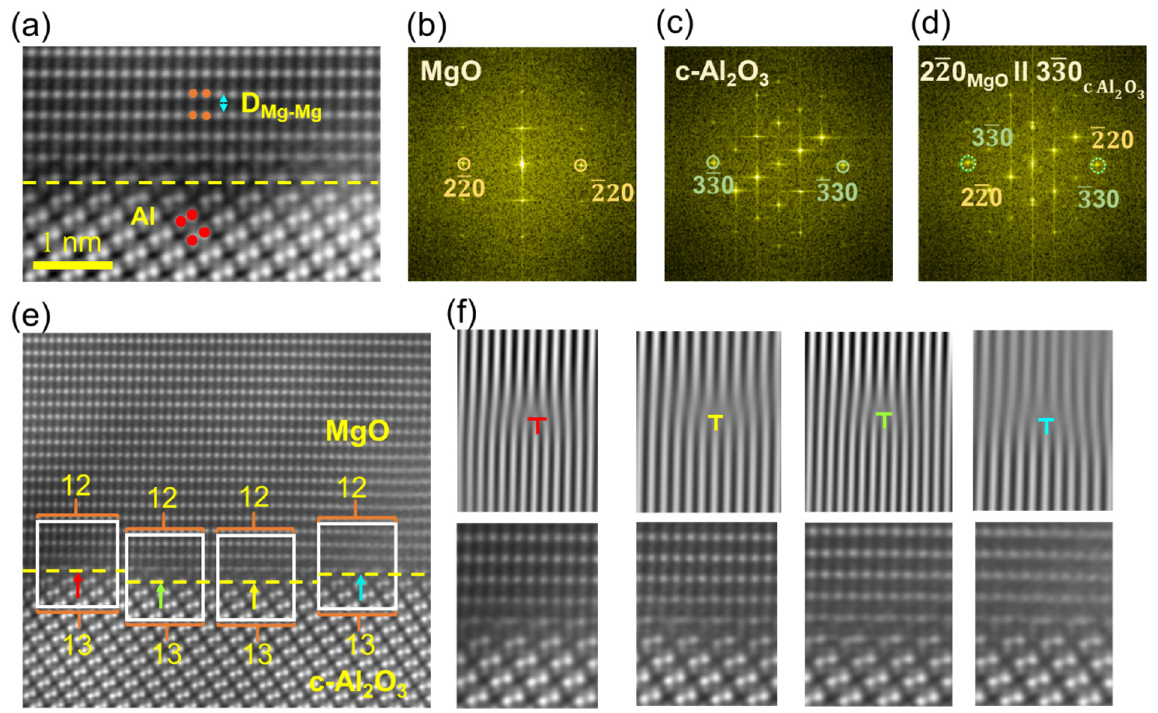
Figure 5. ( a ) HAADF image of MgO film grown on c-Al 2 O 3 . Mg and Al atoms are indicated in orange and red colors. ( b – d ) Electron diffraction spots shown for the respective film, ( e ) HAADF image revealing periodic dislocation formation at the MgO and c-Al 2 O 3 interface with 12/13 planes lattice matching, ( f ) IFFTs along (110) with magnified images of dislocation cores.